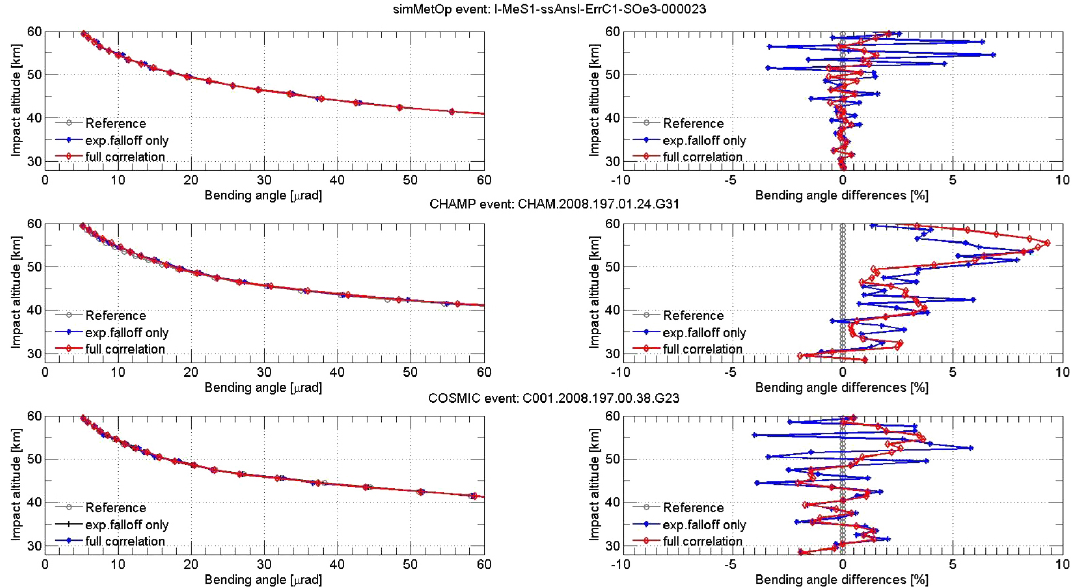
Figure 7. Statistically optimized bending angle profiles together with their reference profile (left) and their difference to the reference profile (right), of three example events from simMetOp (top), CHAMP (middle), and COSMIC (bottom) from 15 July 2008, using either the realistic global-mean correlation matrix of the new dynamic method (“full correlation”) or simple exponential fall-off correlation as existing in OPSv5.6 (“exp.falloff